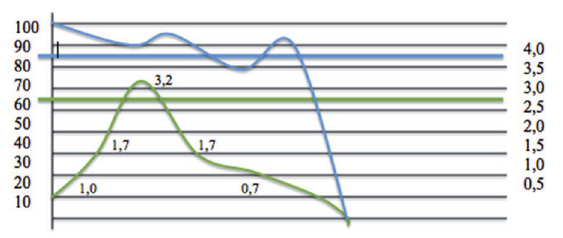
Fig. 2 - Productivity (green line) versus re-work (blue line) (author)